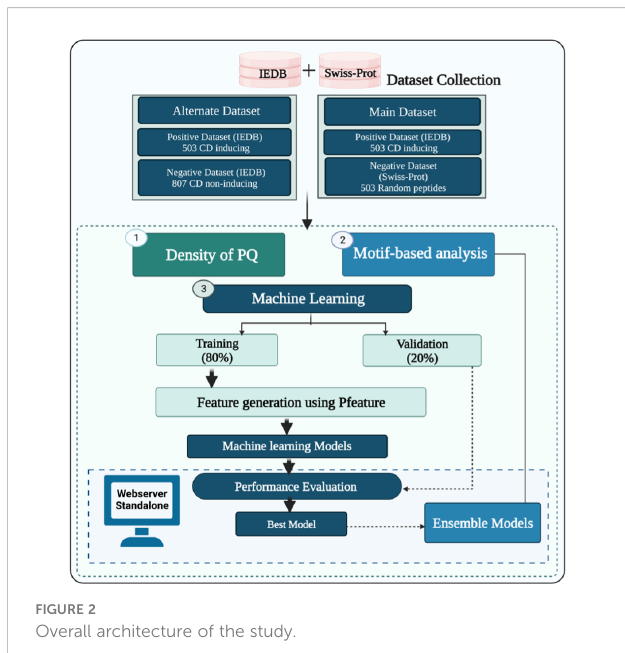
FIGURE 2 Overall architecture of the